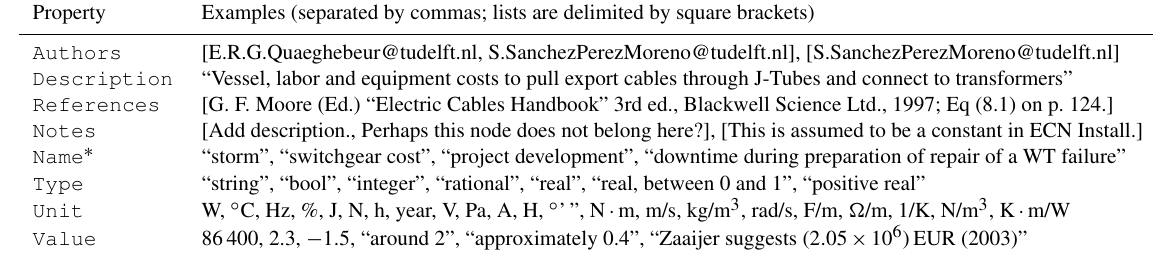
Table 2. Example values for each of the properties defined. Property Examples (separated by commas; lists are delimited by square